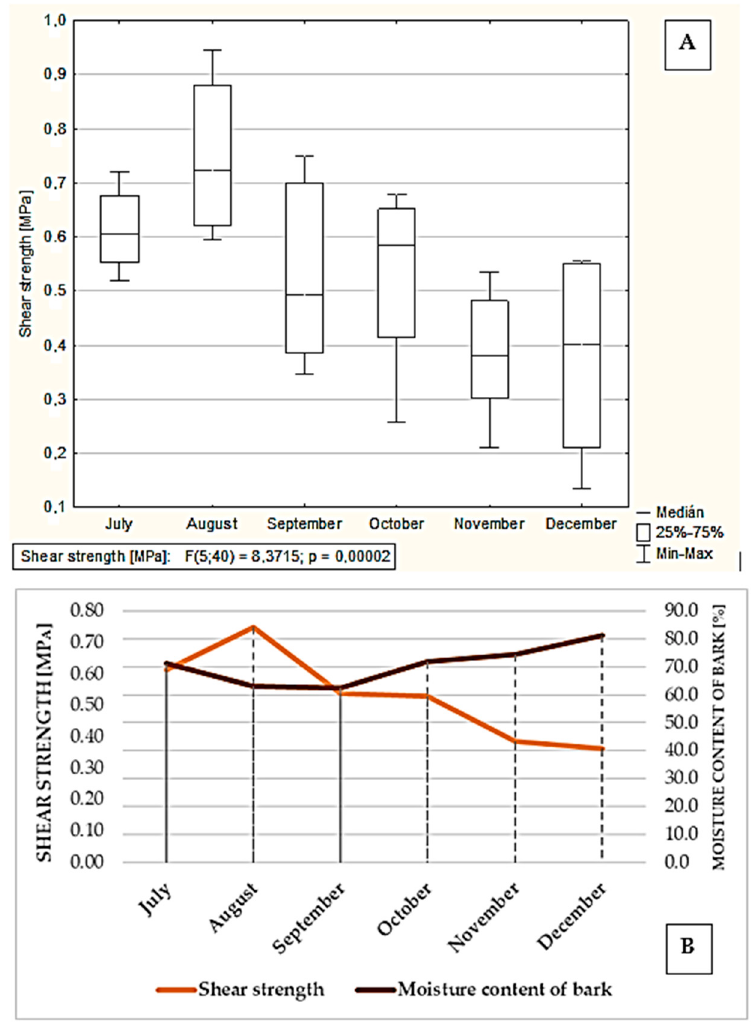
Figure 6. (A) The values of the shear strength at monthly intervals and ( B ) the effect of the moisture content of bark on the shear strength of wood/bark for beech logs.